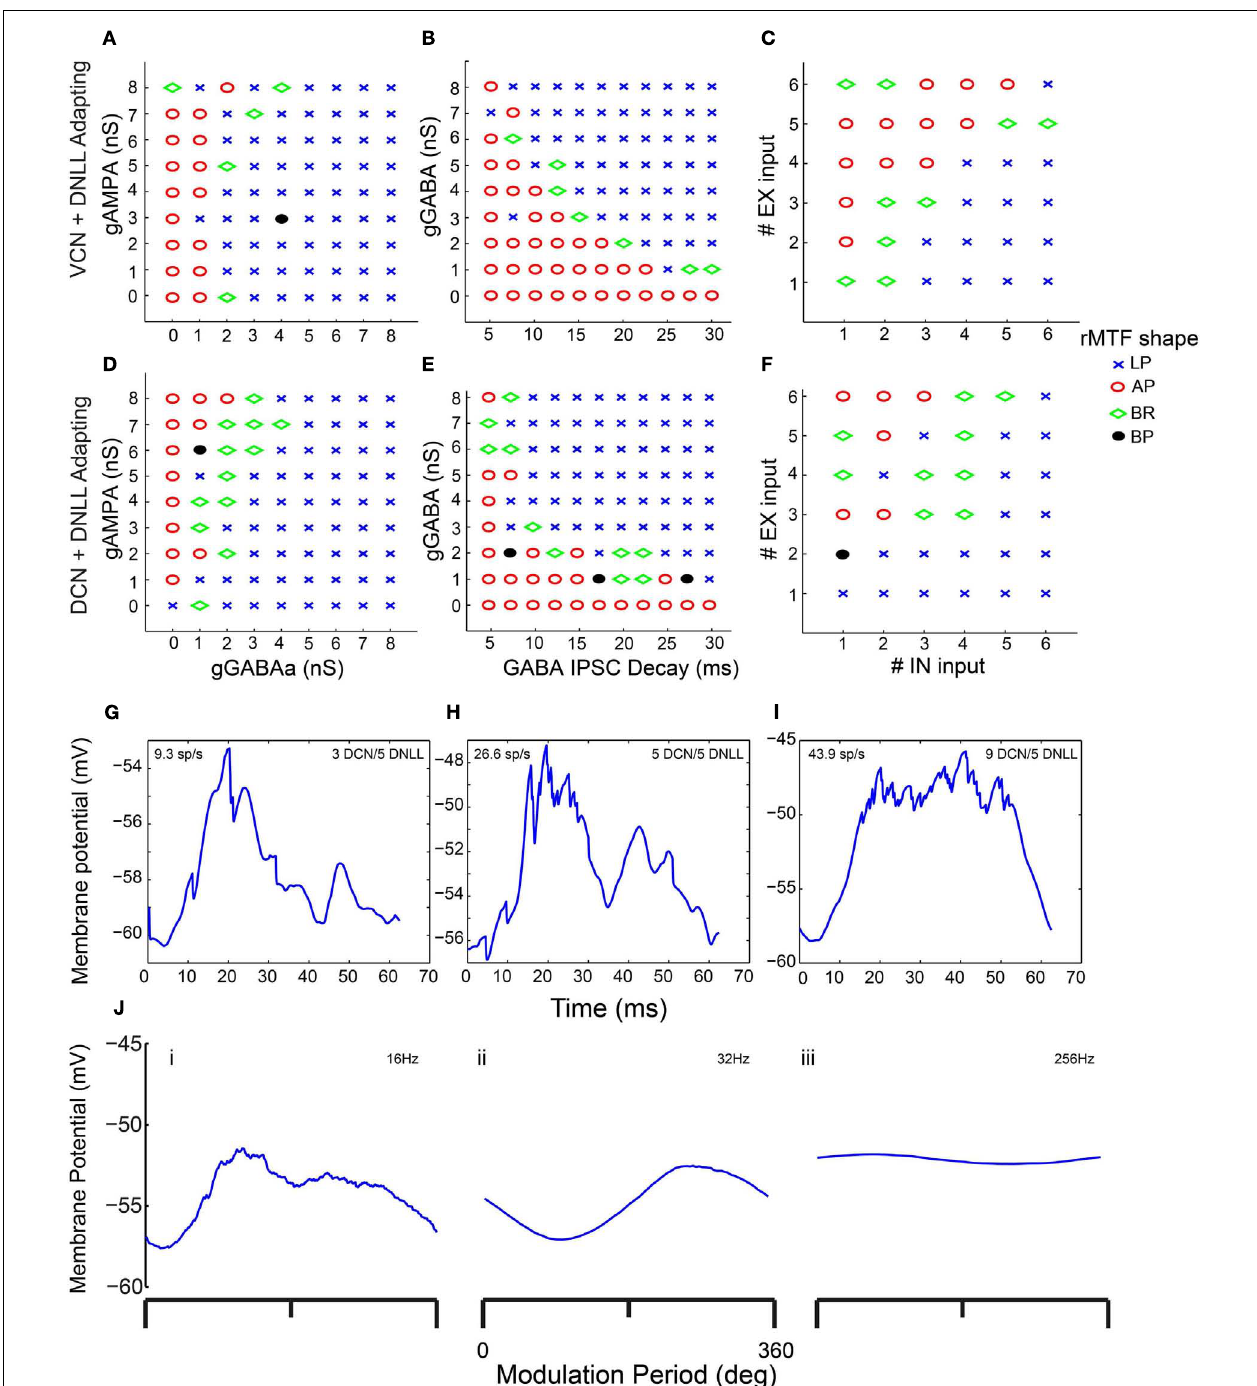
using 4 DCN and 4 DNLL high-pass inputs in the Adapting model. (G–I) Voltage traces taken from a single trial, divided into 62.5ms intervals (16Hz) and averaged. Mean voltage trace from a trial using 3 DCN and 5 DNLL high-pass inputs (G) , 5 DCN and 5 DNLL high-pass inputs (H) , or 9 DCN and 5 DNLL high-pass inputs (I) . Membrane potential is marked along the Y -axis in mV and time is marked along the X -axis in ms. (J) Voltage traces taken from a single trial, divided into either 62.5ms (16Hz, i), 15.6ms (64Hz, ii) or 3.9ms (256Hz, iii) intervals and averaged. Mean voltage traces using 3 DCN and 5 DNLL high pass inputs. Membrane potential is marked along the Y -axis in mV and modulation period is marked along the X -axis in